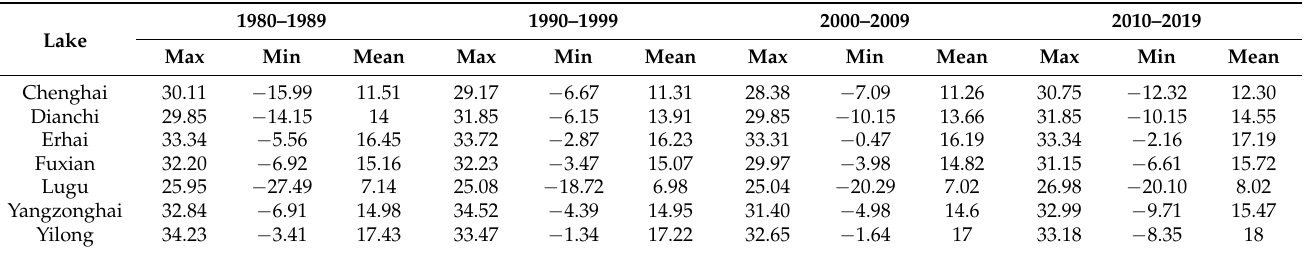
Figure 5. Sudden change point analysis of the annual mean temperatures of lakes on the Yunnan Plateau from 1980 to 2019. Table 4. Maximum, minimum, and average air temperatures (°C) of the Yunnan Plateau lakes per